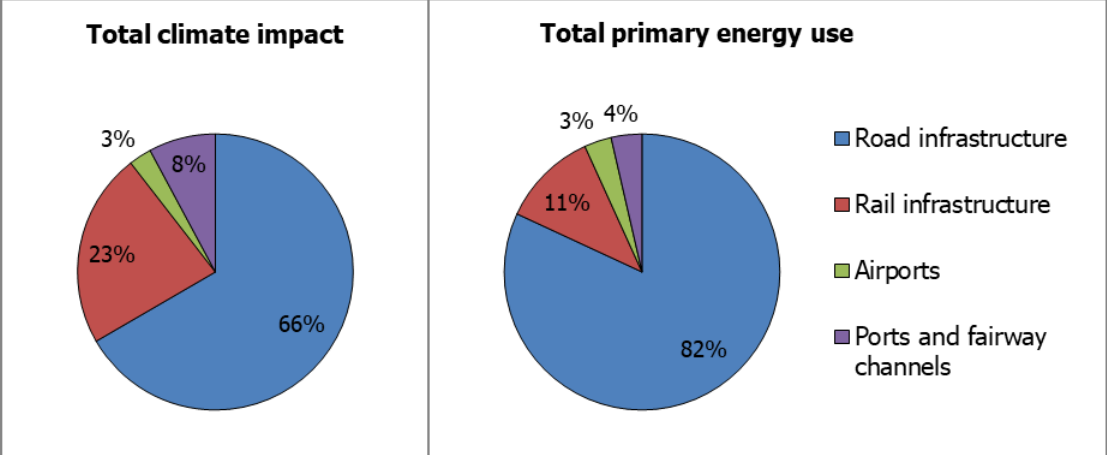
Figure 2. Contribution of road infrastructure, rail infrastructure, airports, and ports and fairway channels to the current annual climate impact and primary energy use of Swedish transport infrastructure The impacts of road and rail infrastructure can be further divided on different ownerships. State-